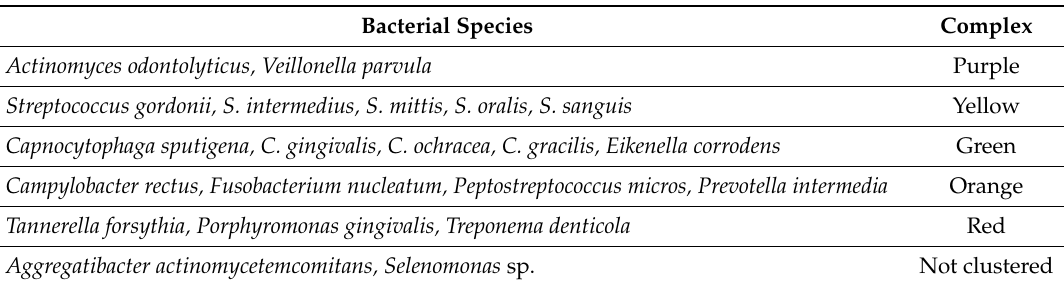
Table 1. Classification of subgingival bacterial complexes [57].